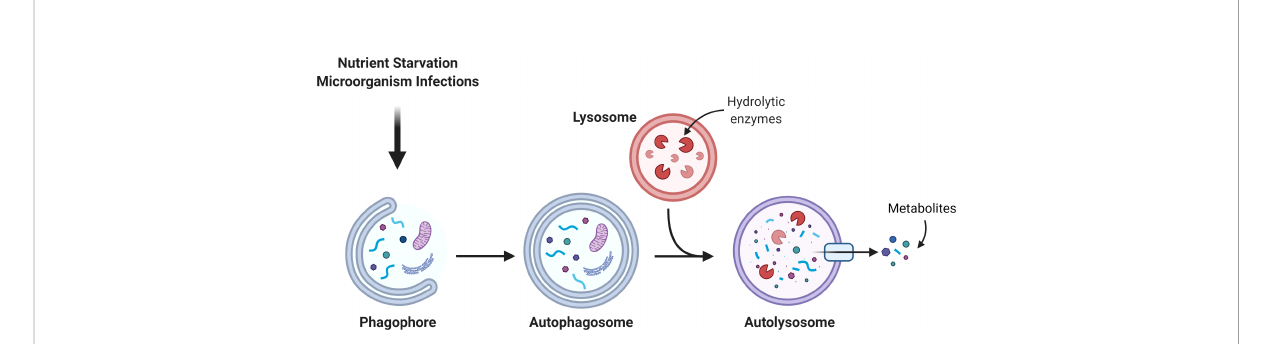
FIGURE 1 Autophagic pathway. The autophagosome is a double membrane organelle which sequesters intracellular material. Then, the autophagosome fuses with the lysosome to form the autolysosome where hydrolytic enzymes promote the degradation of the autolysosome cargo. The catabolism of the cargo generates simple new metabolites that turn back to the cytosol to be used in different metabolic